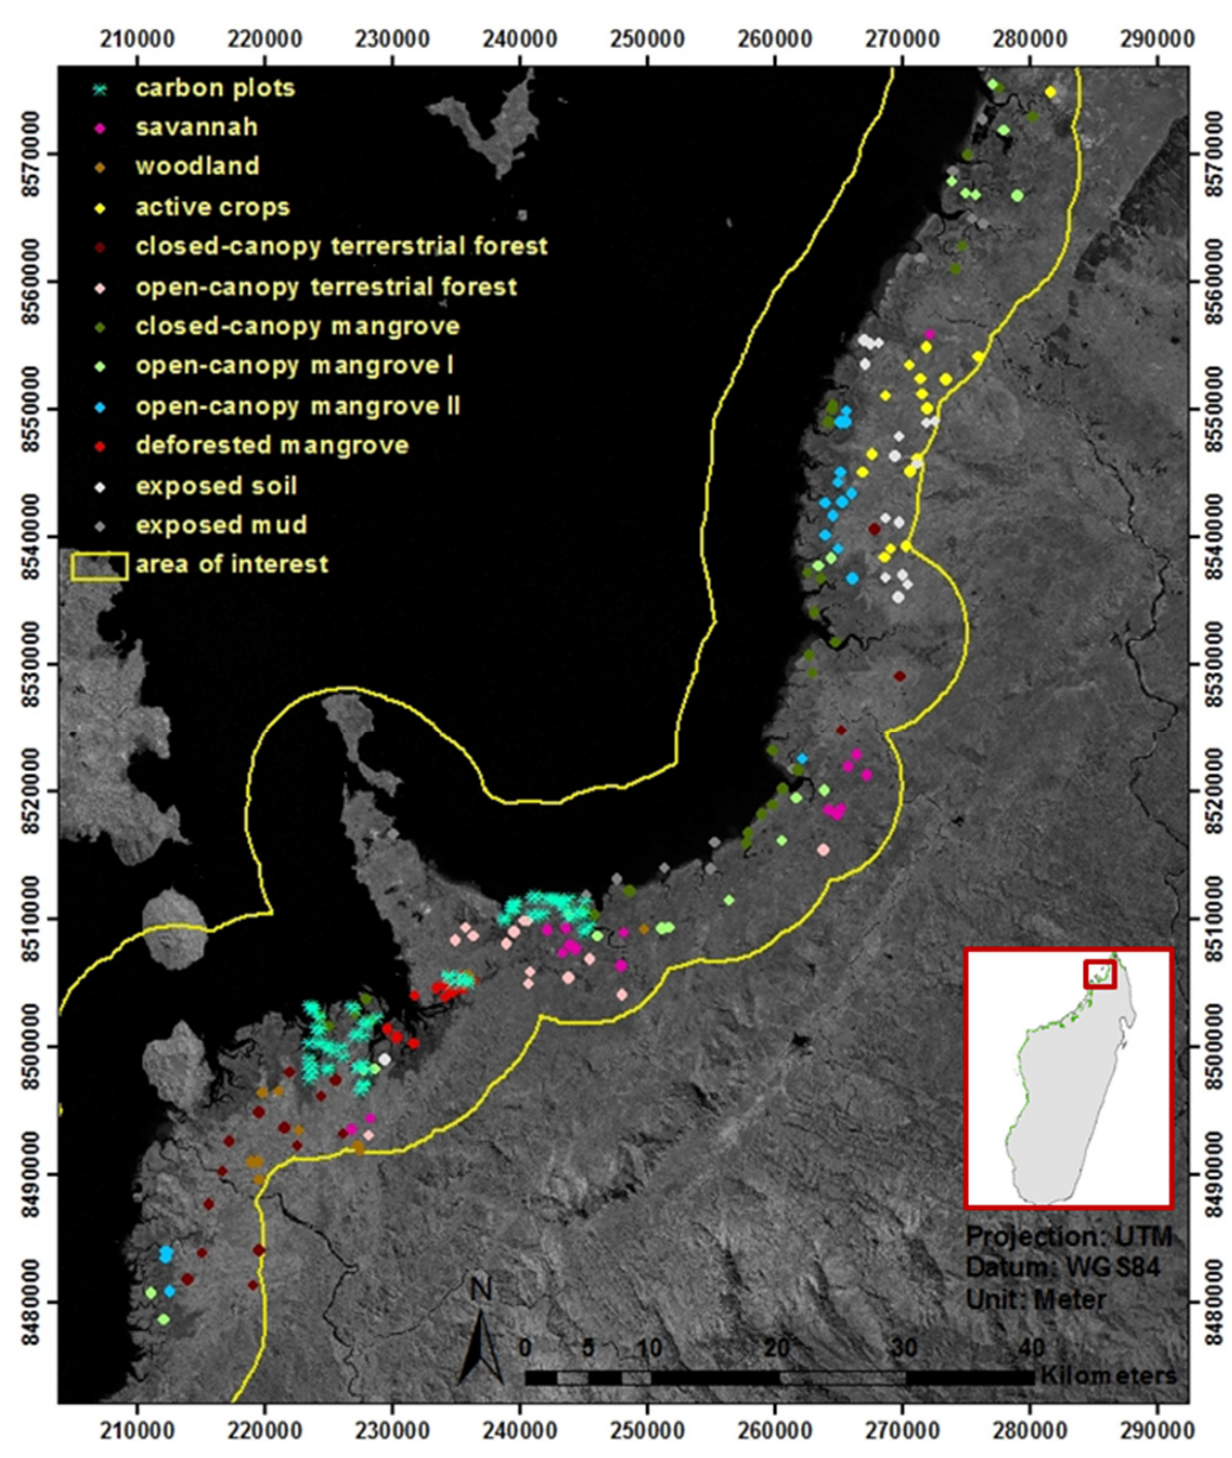
Figure 1. The area of interest includes the combined marine and terrestrial extent encompassed by a seven kilometer coastal buffer of Ambanja and Ambaro bays. One-hundred ninety-one classification reference areas and 55 mangrove carbon plots are shown. The background image is the near-infrared band ( i.e. , band 4) from a (Global Land Survey) GLS 2010 Landsat image, projected to Universal Transverse Mercator